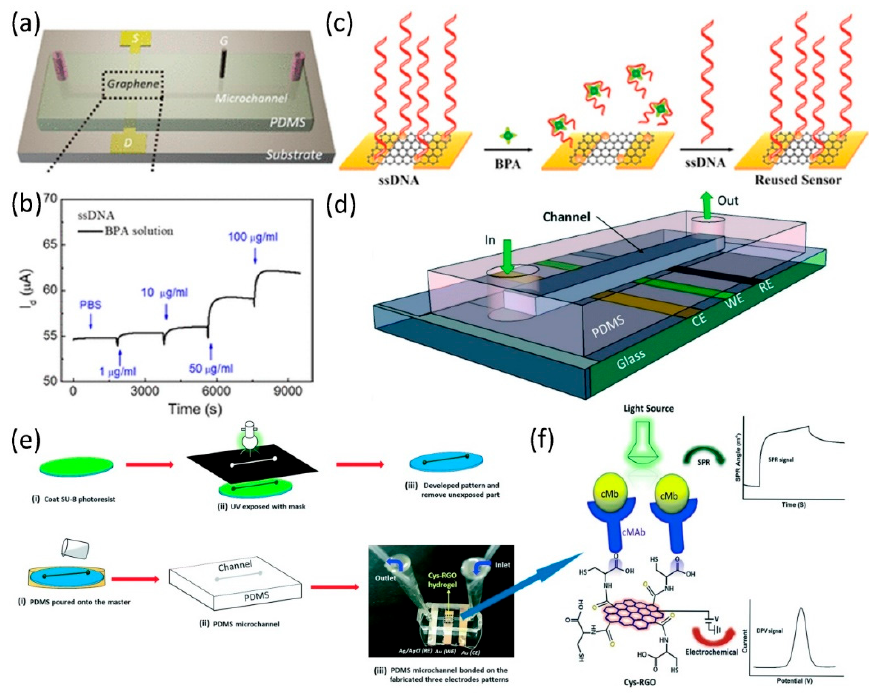
Figure 8. ( a ) Schematic diagram of a functionalized graphene transistor biosensor. ( b ) The time- dependent I d for different concentrations of bisphenol A (BPA) solutions. ( c ) Schematic representation of the ssDNA molecule detaching from the graphene surface and binding again. Reproduced from [101] with the permission from American Chemical Society. ( d ) Schematic diagram of a microfluidic biosensor chip for cMb detection. ( e ) Flowchart for the preparation of Cys-rGO hydrogel microfluidic biosensor chips. ( f ) Cys-rGO microfluidic biosensor sensing mechanism and its detected signal response. Reproduced from [102] with the permission from American Chemical Society.